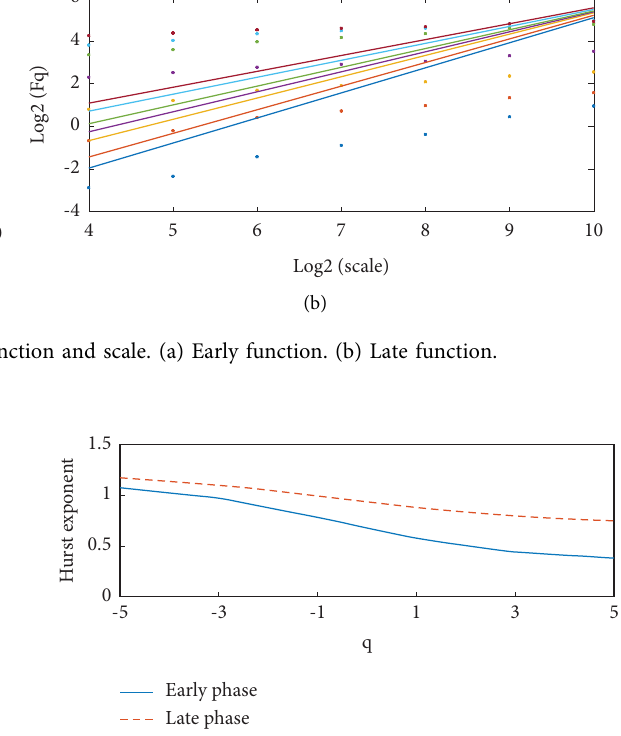
Figure 14: Hurst exponents at the early and late phases. Table 2: Hurst exponent of the nonlinear vibration signal of the cylinder